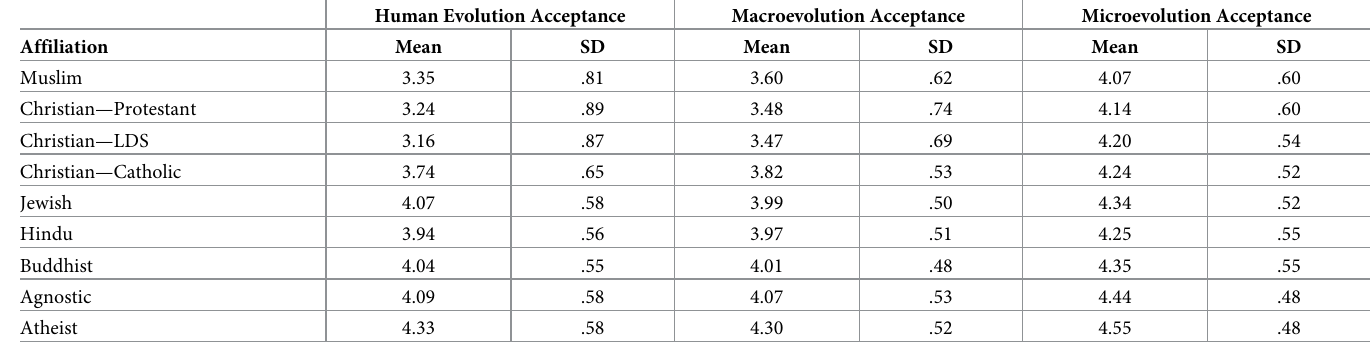
Table 6. The mean and standard deviation of human evolution acceptance, macroevolution acceptance, and microevolution acceptance scores disaggregated by reli- gious